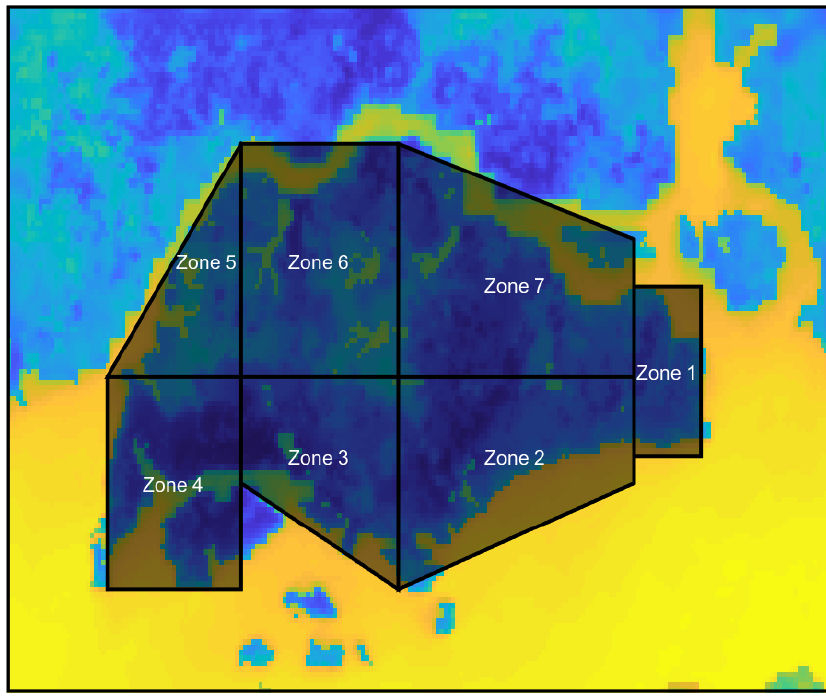
Figure 12. Spatial partition of Singapore to seven non-overlapping allocation zones.